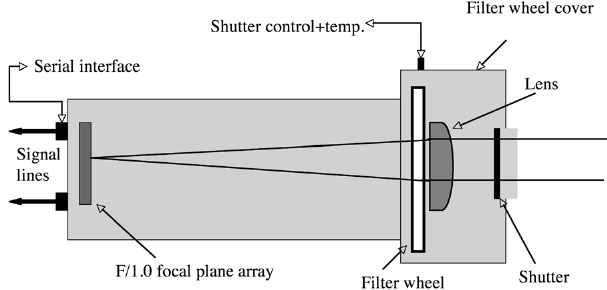
Figure 1. Schematic showing the main components of the “Cy- clops” thermal imaging infrared camera. Note that the filter wheel, containing up to 5 filters, is placed behind the lens.